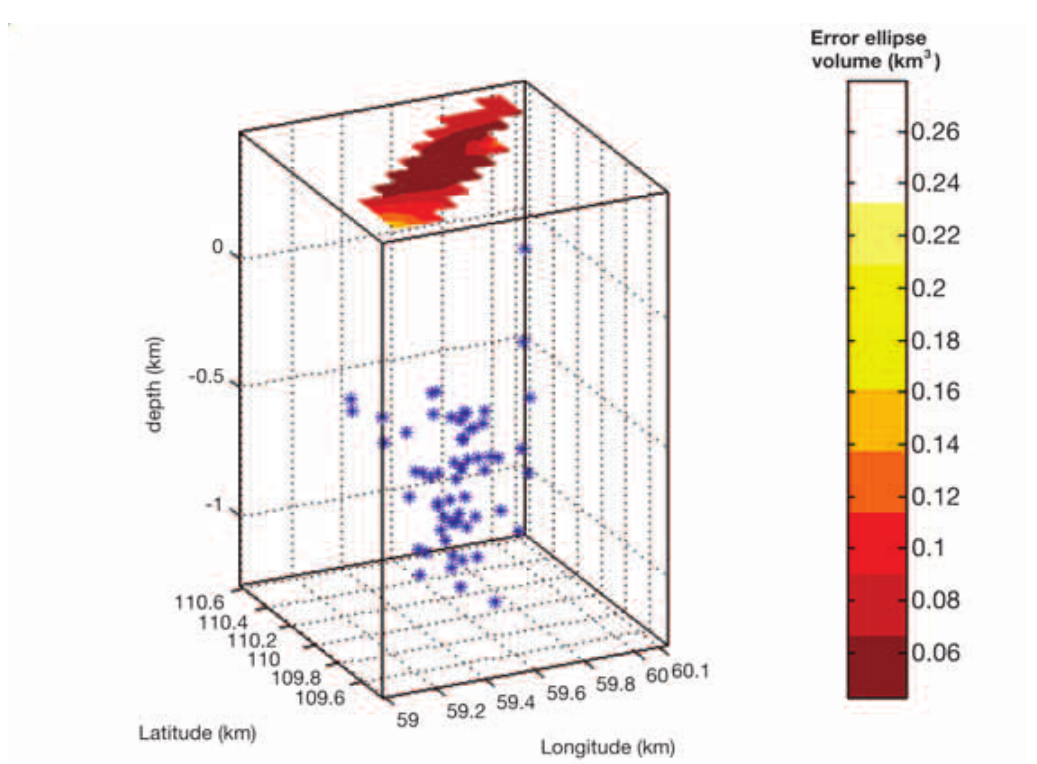
Fig. 9. Three-dimensional view of the locations with the three axes of the error ellipses, in addition a coloured evaluation of the error ellipse volumes is shown in the horizontal